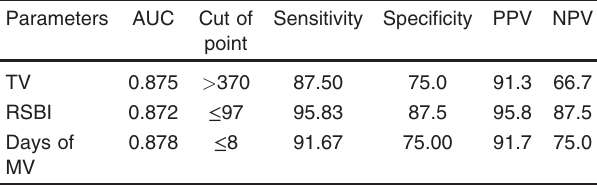
Table 5 Receiver operating characteristic for tidal volume, rapid shallow breathing index, and days of mechanical ventilation as predictors of successful weaning Parameters AUC Cut of point